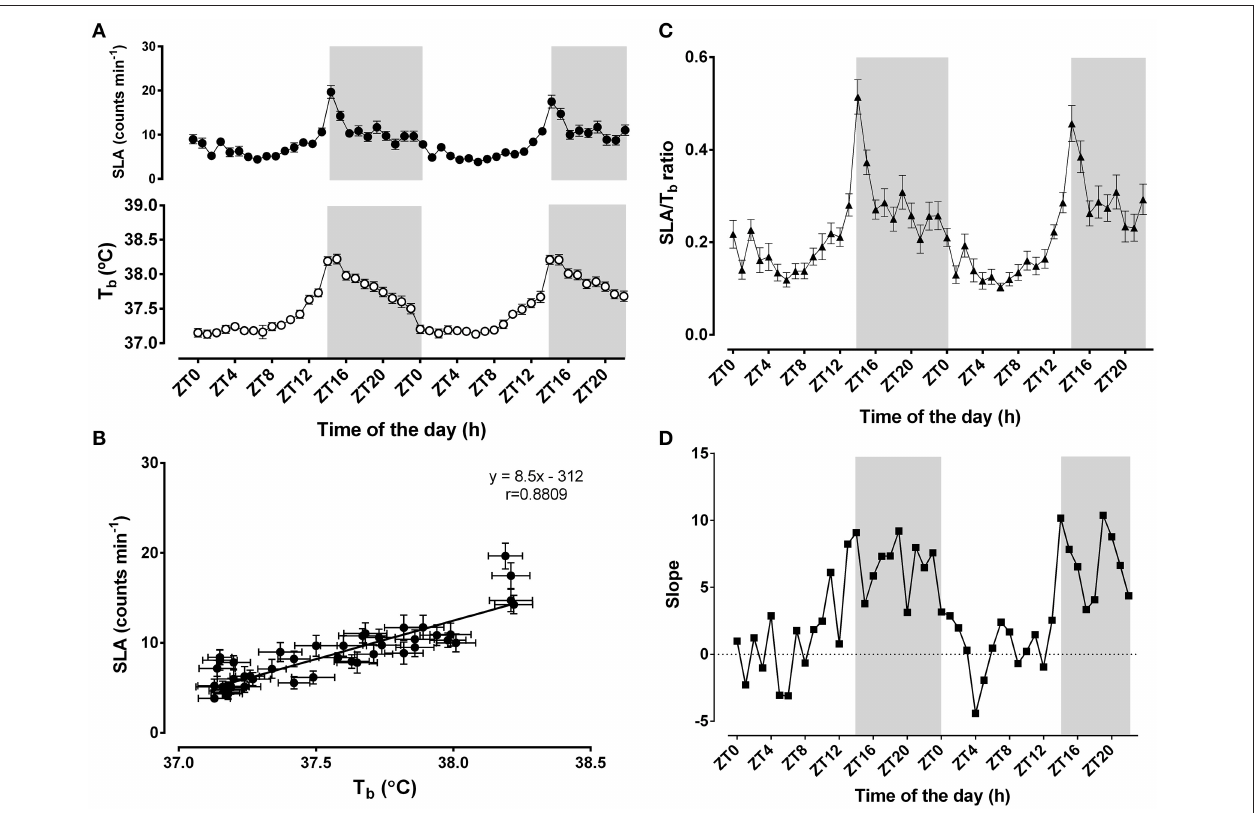
FIGURE 1 | Daily changes in body temperature (T b )and locomotor activity (SLA). In (A) ( top panel ), black circles correspond to 1-h moving averages of SLA (counts min − 1 ), and white circles ( bottom panel) represent T b ( ◦ C). Light/Dark cycles were set at 14/10; the light-phase started at 06:00 (ZT0) when the lights were turned on; the dark-phase (shaded gray background) started at 20:00 (ZT14). In (B) , the associations between the daily changes in body temperature and SLA were represented as the correlation between the 24h-averages of body temperature and SLA. The linear correlation equation and the representative line were added to the graphic. Pearson’s r coefficient was 0.8809 and p < 0.0001. In (C,D) , the ratios between SLA and T b (black triangles) and the slopes of the linear regressions at each hour (black squares) were plotted as a function of time-of-day. The results are expressed as the mean ± SEM, except for the slope panel ( n =